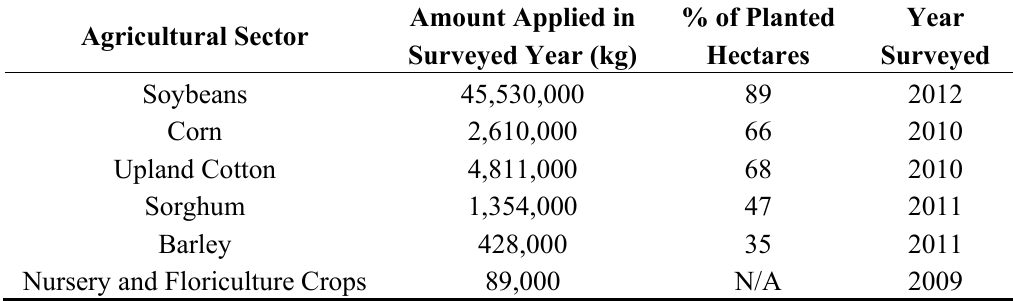
Table 1. Summary of glyphosate application in the United States for a given agricultural sector for a given year, as well as the percentage of hectares planted that received glyphosate